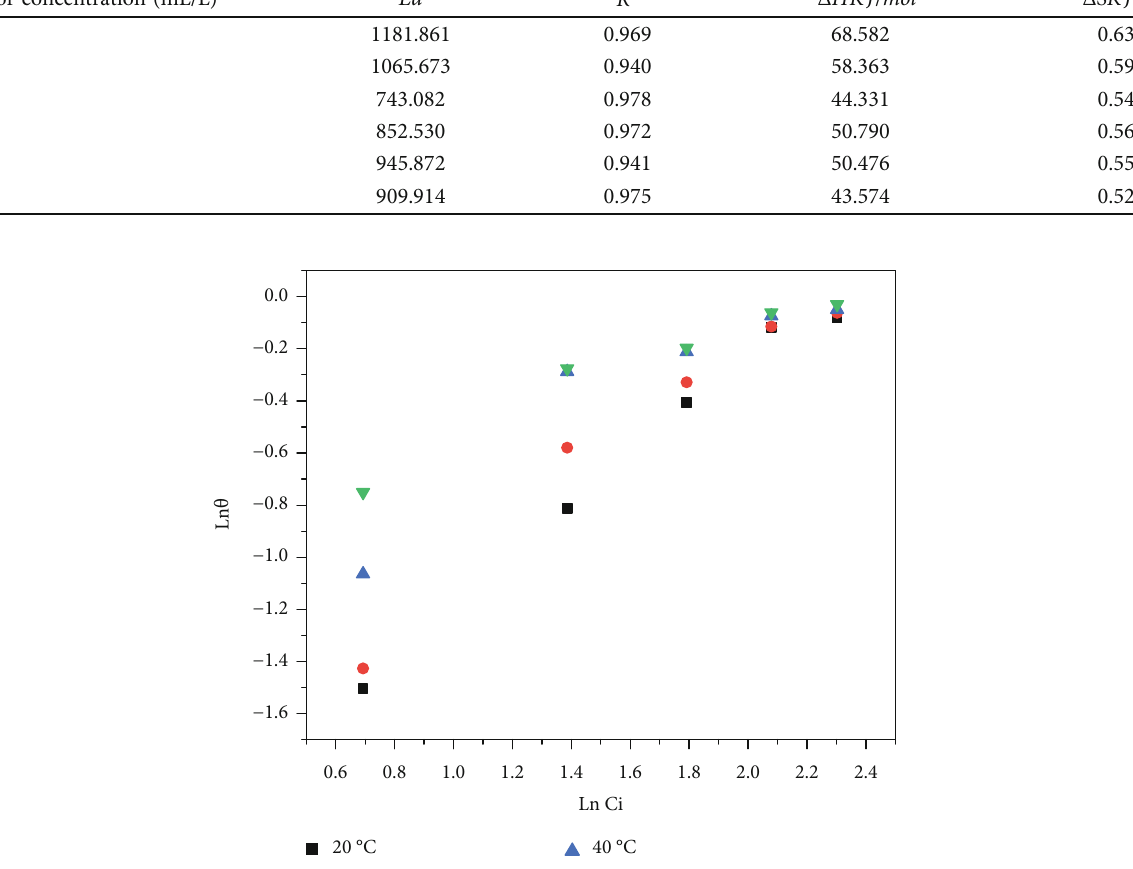
Table 3: Enthalpy, entropy, and activation energy of the Aluminium corrosion reaction with di ff erent concentrations of PDL extract. Inhibitor concentration (mL/L) Ea